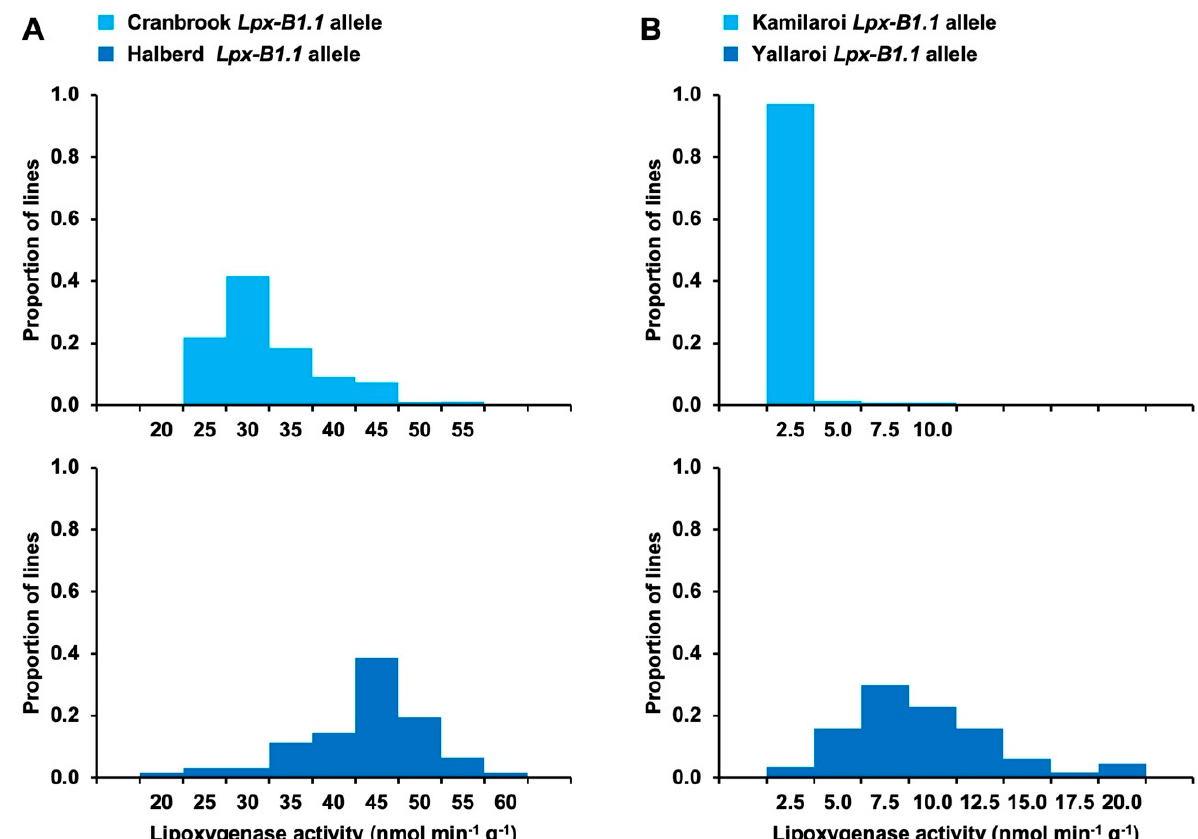
Figure 3. Lipoxygenase activity in ( A ) Cranbrook/Halberd and ( B ) Kamilaroi/Yallaroi. Upper panels show the phenotypic frequency distributions for lines that are homozygous for the Lpx-B1.1 deletion allele from ( A ) Cranbrook and ( B ) Kamilaroi. Lower panels show the phenotypic frequency distributions for lines that are homozygous for the Lpx-B1.1 alleles from ( A ) Halberd and ( B ) Yallaroi.